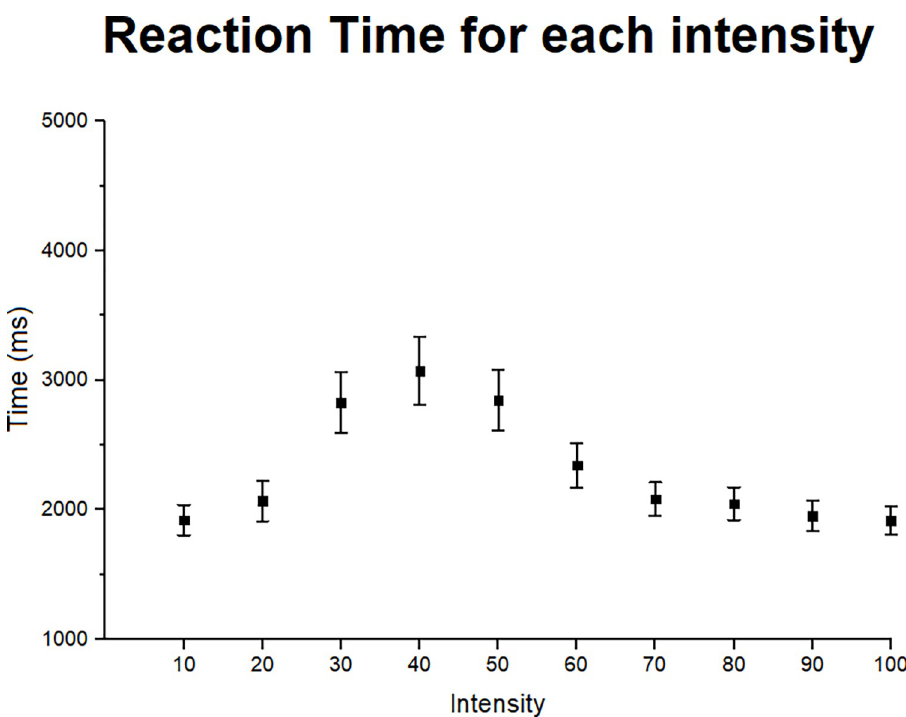
Fig 4. RT for each intensity. RT means and standard errors for each intensity with all emotions and odor conditions grouped.